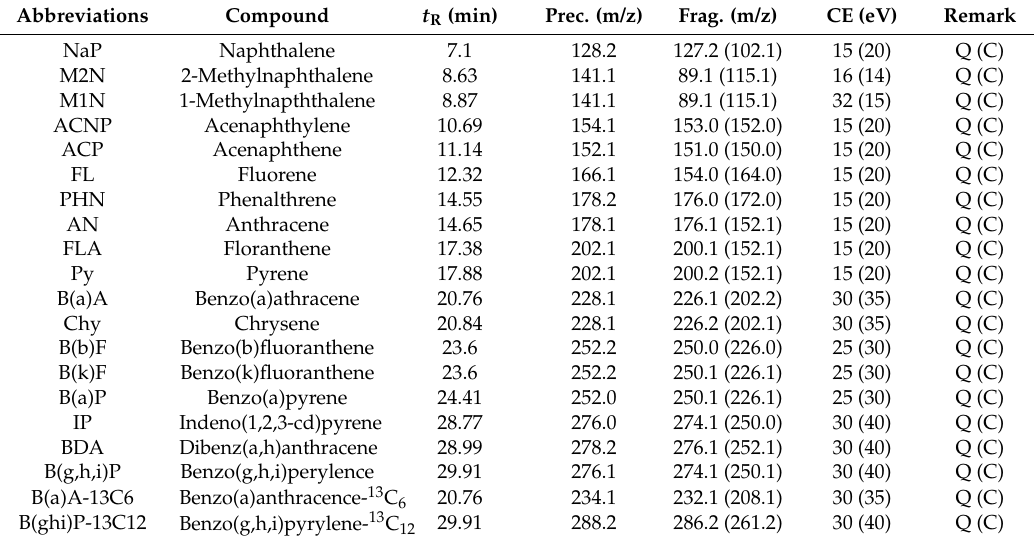
Table 1. Identifying, quantifying ions, retention time, and collision energy of 20 polycyclic aromatic hydrocarbons